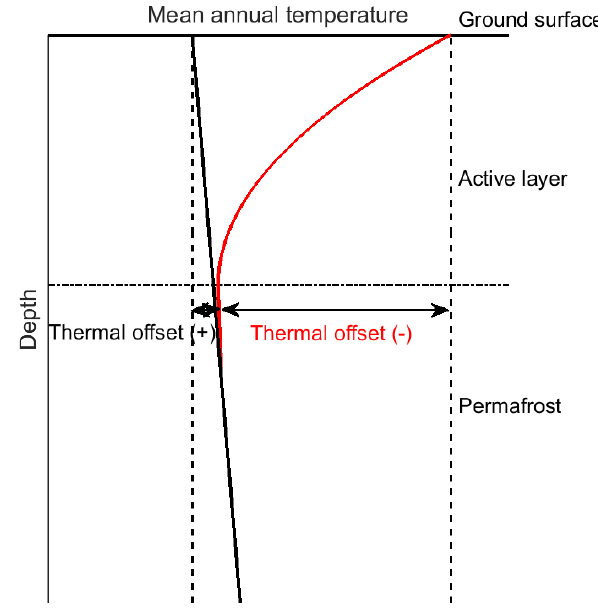
Figure 11. Schematic mean annual ground temperature for two types of permafrost. Black curve shows the studied permafrost with positive thermal offset and red curve shows common permafrost with negative thermal